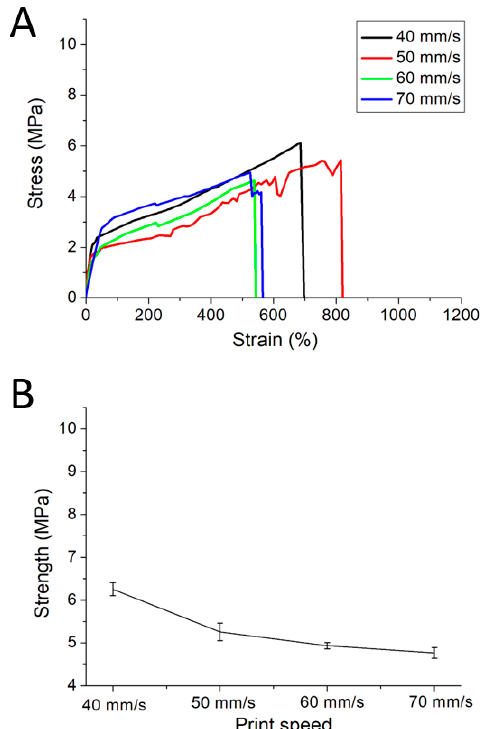
Figure 6. Effect of fill density on the mechanical properties of additively manufactured PCL parts (A: stress strain curves; B: maximum tensile strengths, other parameters used were those of Level 2 in Table 1). Appl. Sci. 2020 , 10 , x FOR PEER REVIEW